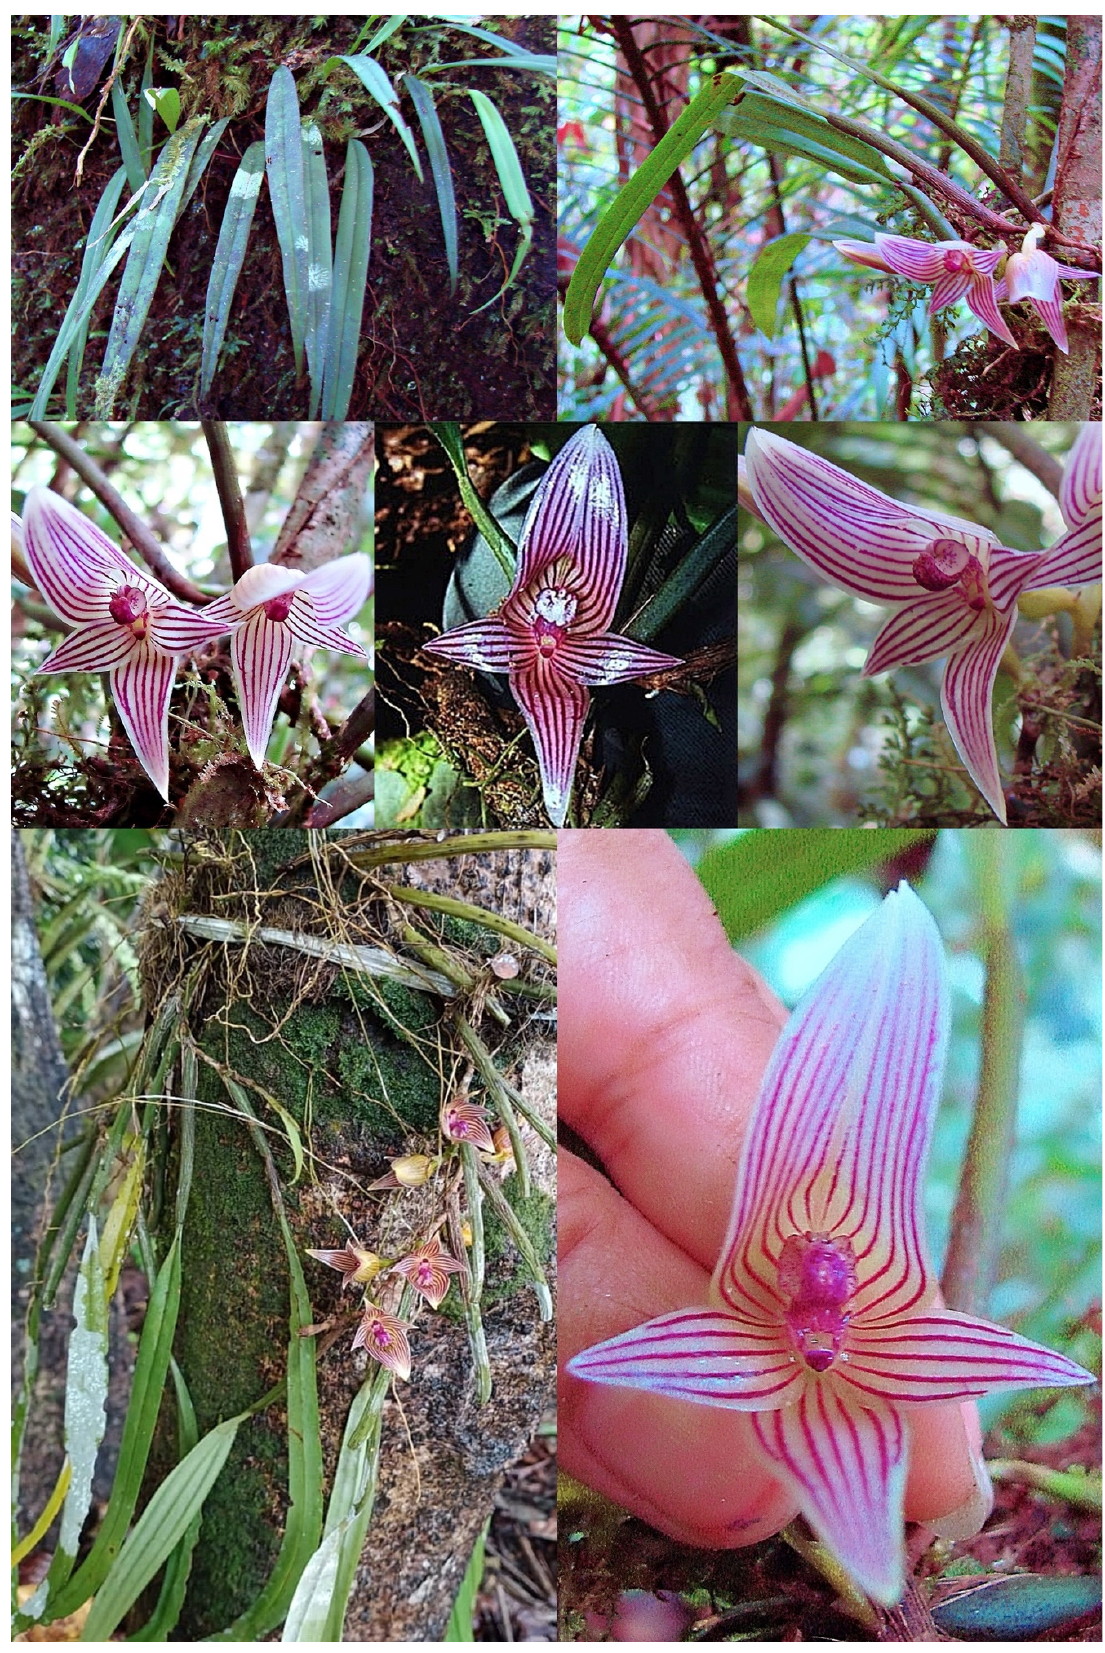
Figure 3. Plants in the wild and ex situ.